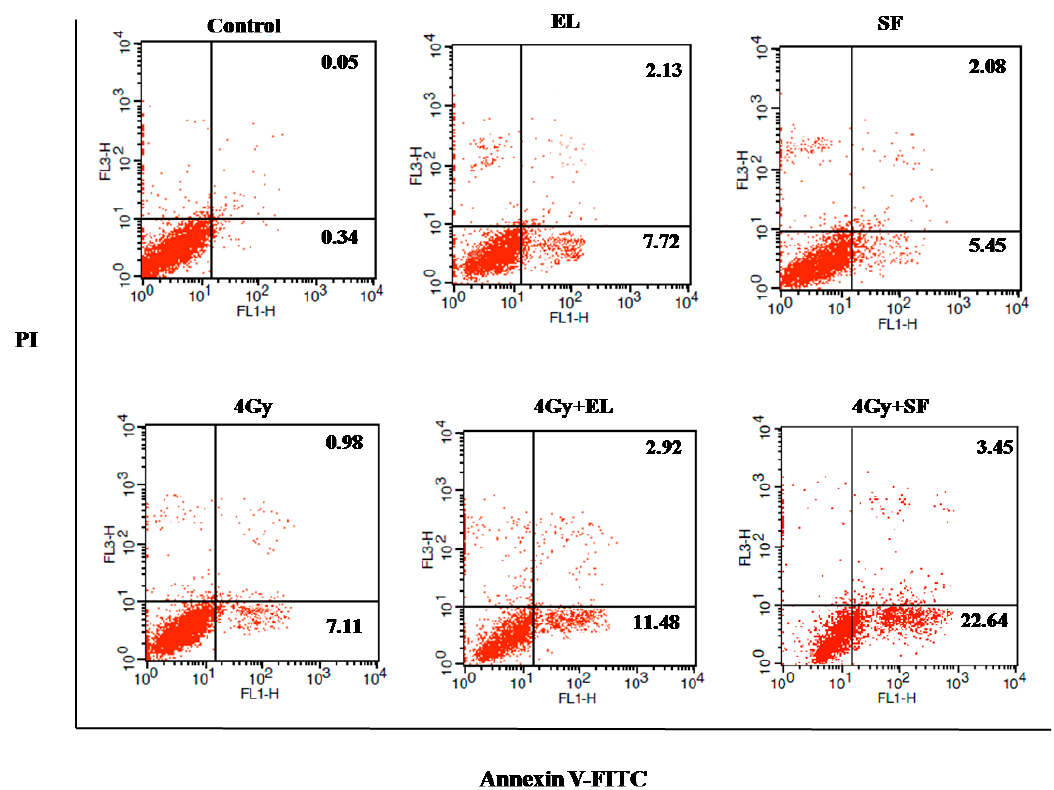
Figure 5. The radiosensitivity effects of β -Elemene (EL, 15 µg/mL) and schinifoline (SF, 4 µg/mL) treatment on apoptosis in A549 cells by the FACS analysis. The viable cells (Annexin V and PI negative) are in the lower left-hand quadrant. Early apoptotic cells (Annexin V positive/PI negative) are in the lower right-hand quadrant. Terminal apoptotic (Annexin V and PI positive) are in the upper right-hand